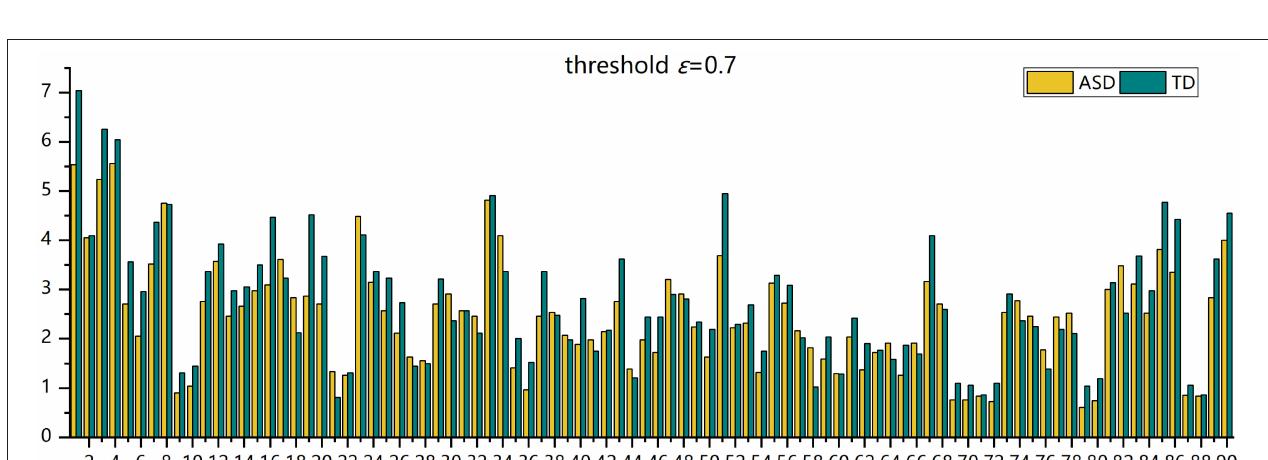
FIGURE 6 | The histogram of the average number of FC neural circuits in each brain region in AAL in the ASD group and the TD control